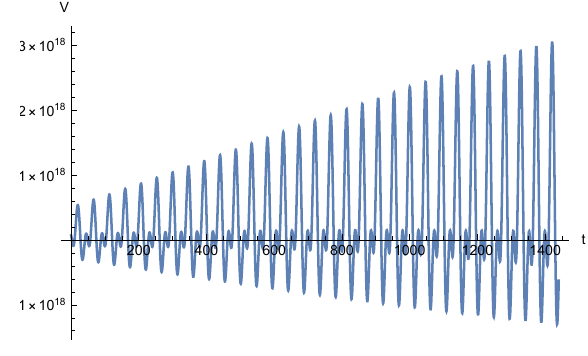
Fig. 7 Visibility Intervals Between CFESAT and MTI For 24-H with Oblateness